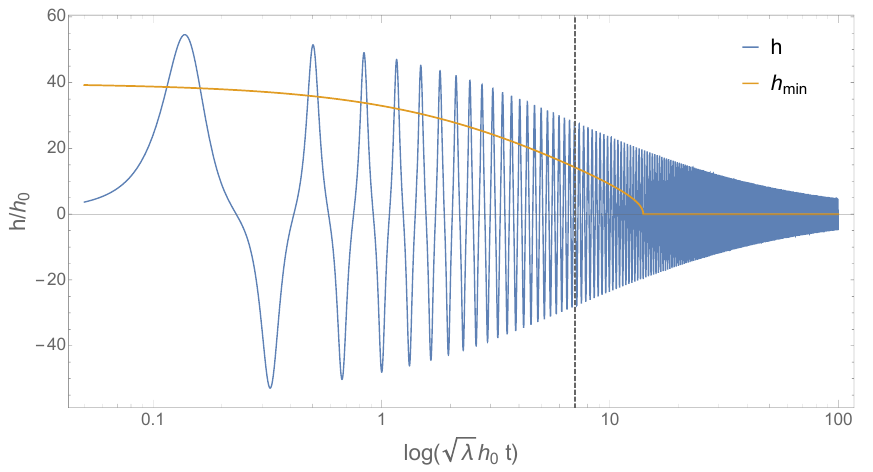
Figure 7 . Higgs relaxation from forced initial conditions. The parameters are (cid:3) = 10 16 GeV, (cid:3) I = 2 (cid:2) 10 14 GeV, (cid:0) I = 10 6 GeV, and (cid:21) = 0 : 001. The blue line shows the evolution of the Higgs VEV during reheating. The yellow line shows the positive minimum of the Higgs potential. The dashed line indicates the time when maximal temperature is